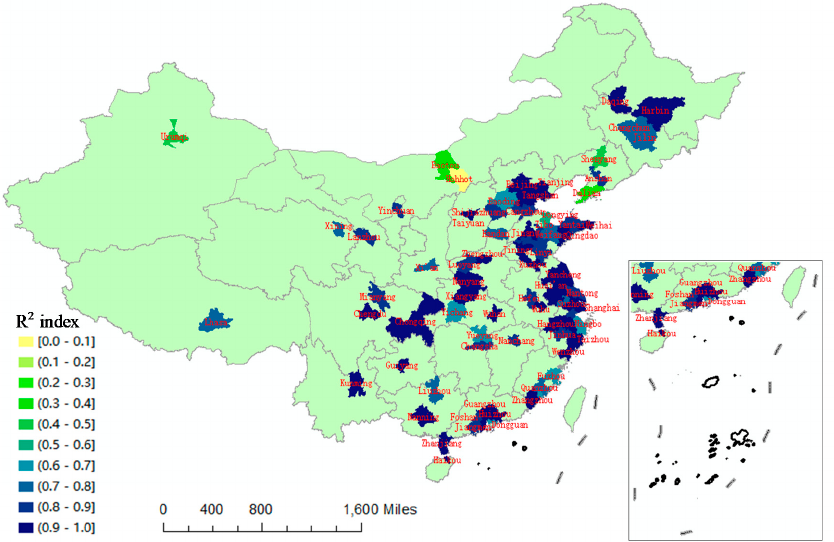
Figure 4. Distribution of R 2 calculated by the OSM road network density.